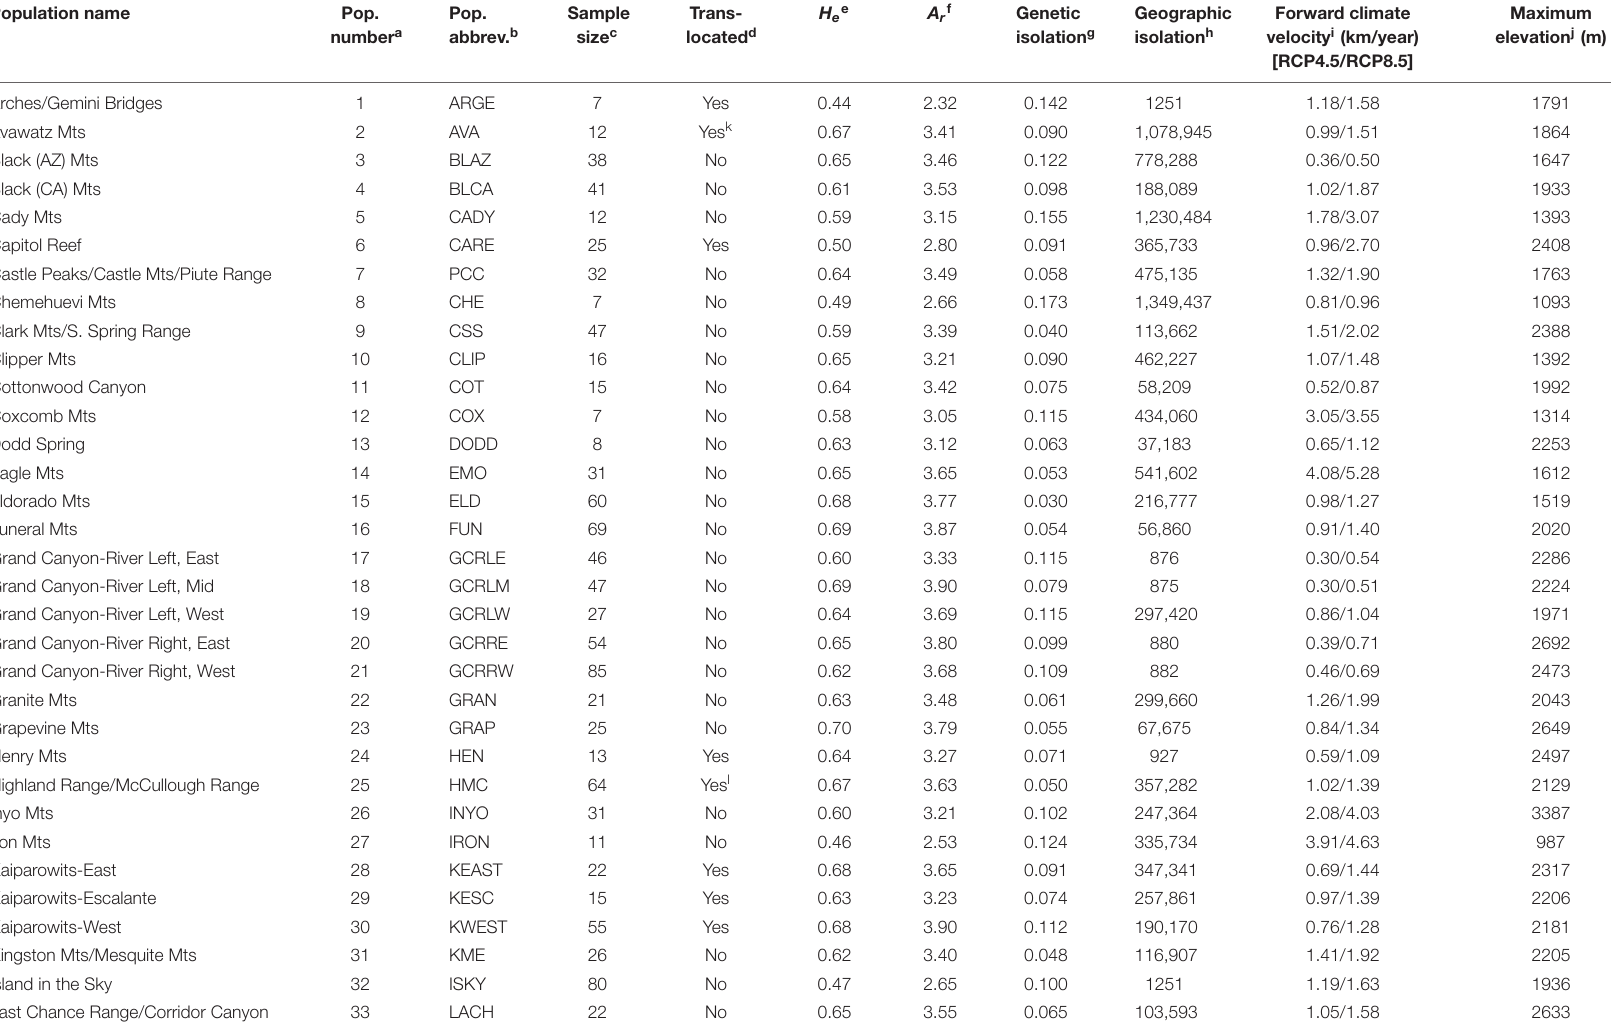
TABLE 1 | Characteristics of 62 desert bighorn sheep populations in the study area, including translocation history, genetic diversity, geographic and genetic isolation, forward climate velocity, and maximum